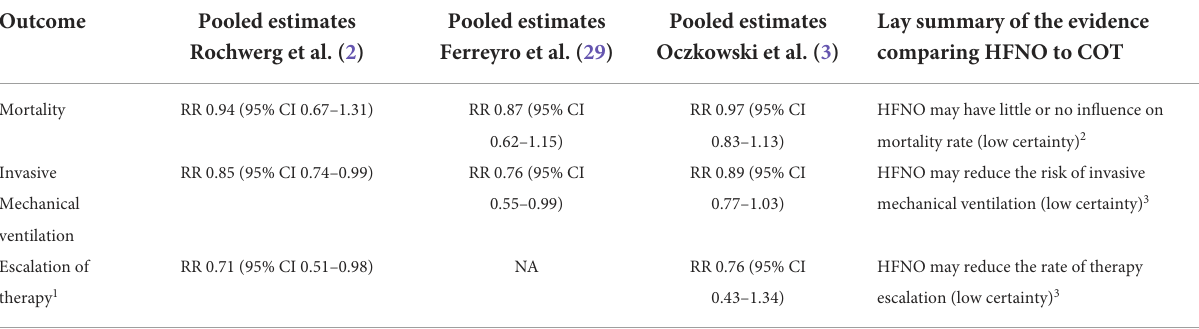
TABLE 1 Pooled effect estimates of high-flow nasal oxygen compared to conventional oxygen therapy before the COVID pandemic.